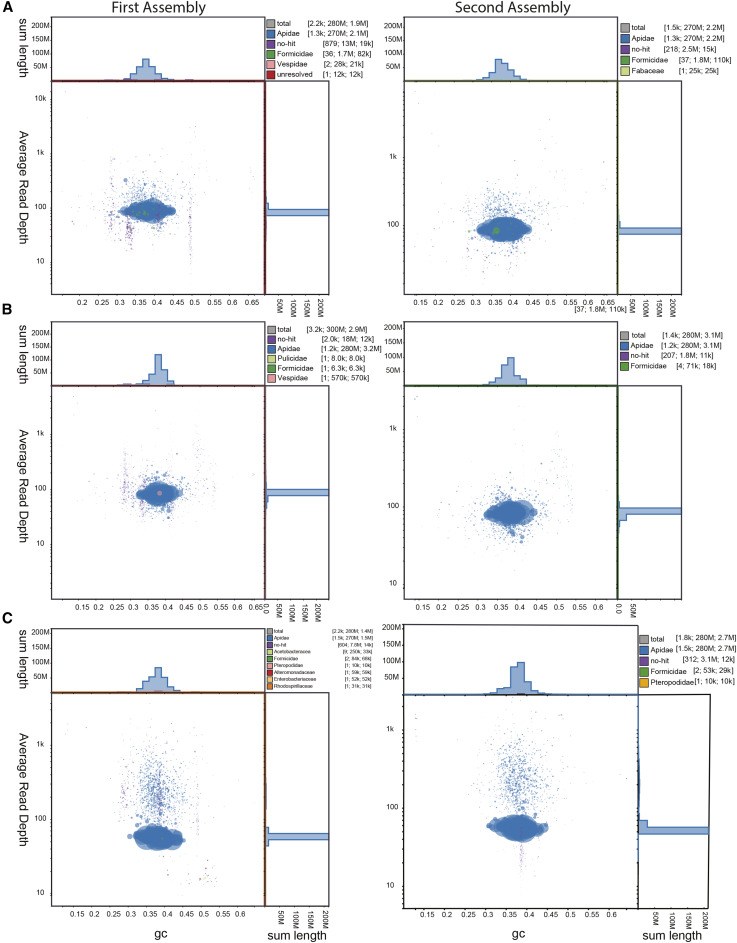
Blob plots (from Illumina data) showing read depth of coverage, GC content, and size for each scaffold after first (left hand column) and second round (right hand column) MaSuRCA assemblies for A) Bombus bifarius, B) Bombus vancouverensis, C) Bombus vosnesenskii. Size of the blob corresponds to size of the scaffold and color corresponds to taxonomic assignment of BLAST (blue = Apidae). Inset statistics for each panel refer to [scaffold count, sum length, N50] associated with BLAST assignments to each taxonomic group. The top and right histograms indicate the total length of scaffolds at a given GC content or average read depth, respectively. Qualitatively similar plots were produced using the ONT data.